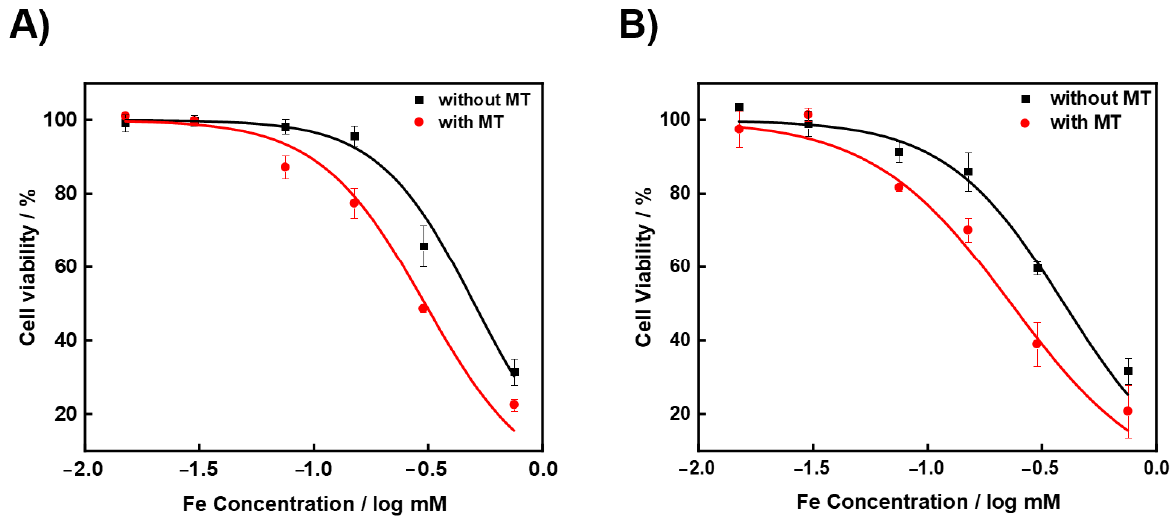
Figure 3. U87 cell viability of PEGNIO/QDs/MIONs ( A ) and PEGNIO/QDs/MIONs/Tf ( B ) at different concentrations with (with MT) or without (without MT) a preceding magnetic treatment. For the calculated half inhibition concentrations (IC 50 ), we evaluated p < 0.05 by using the Student’s t -test, which is thus considered as significant.